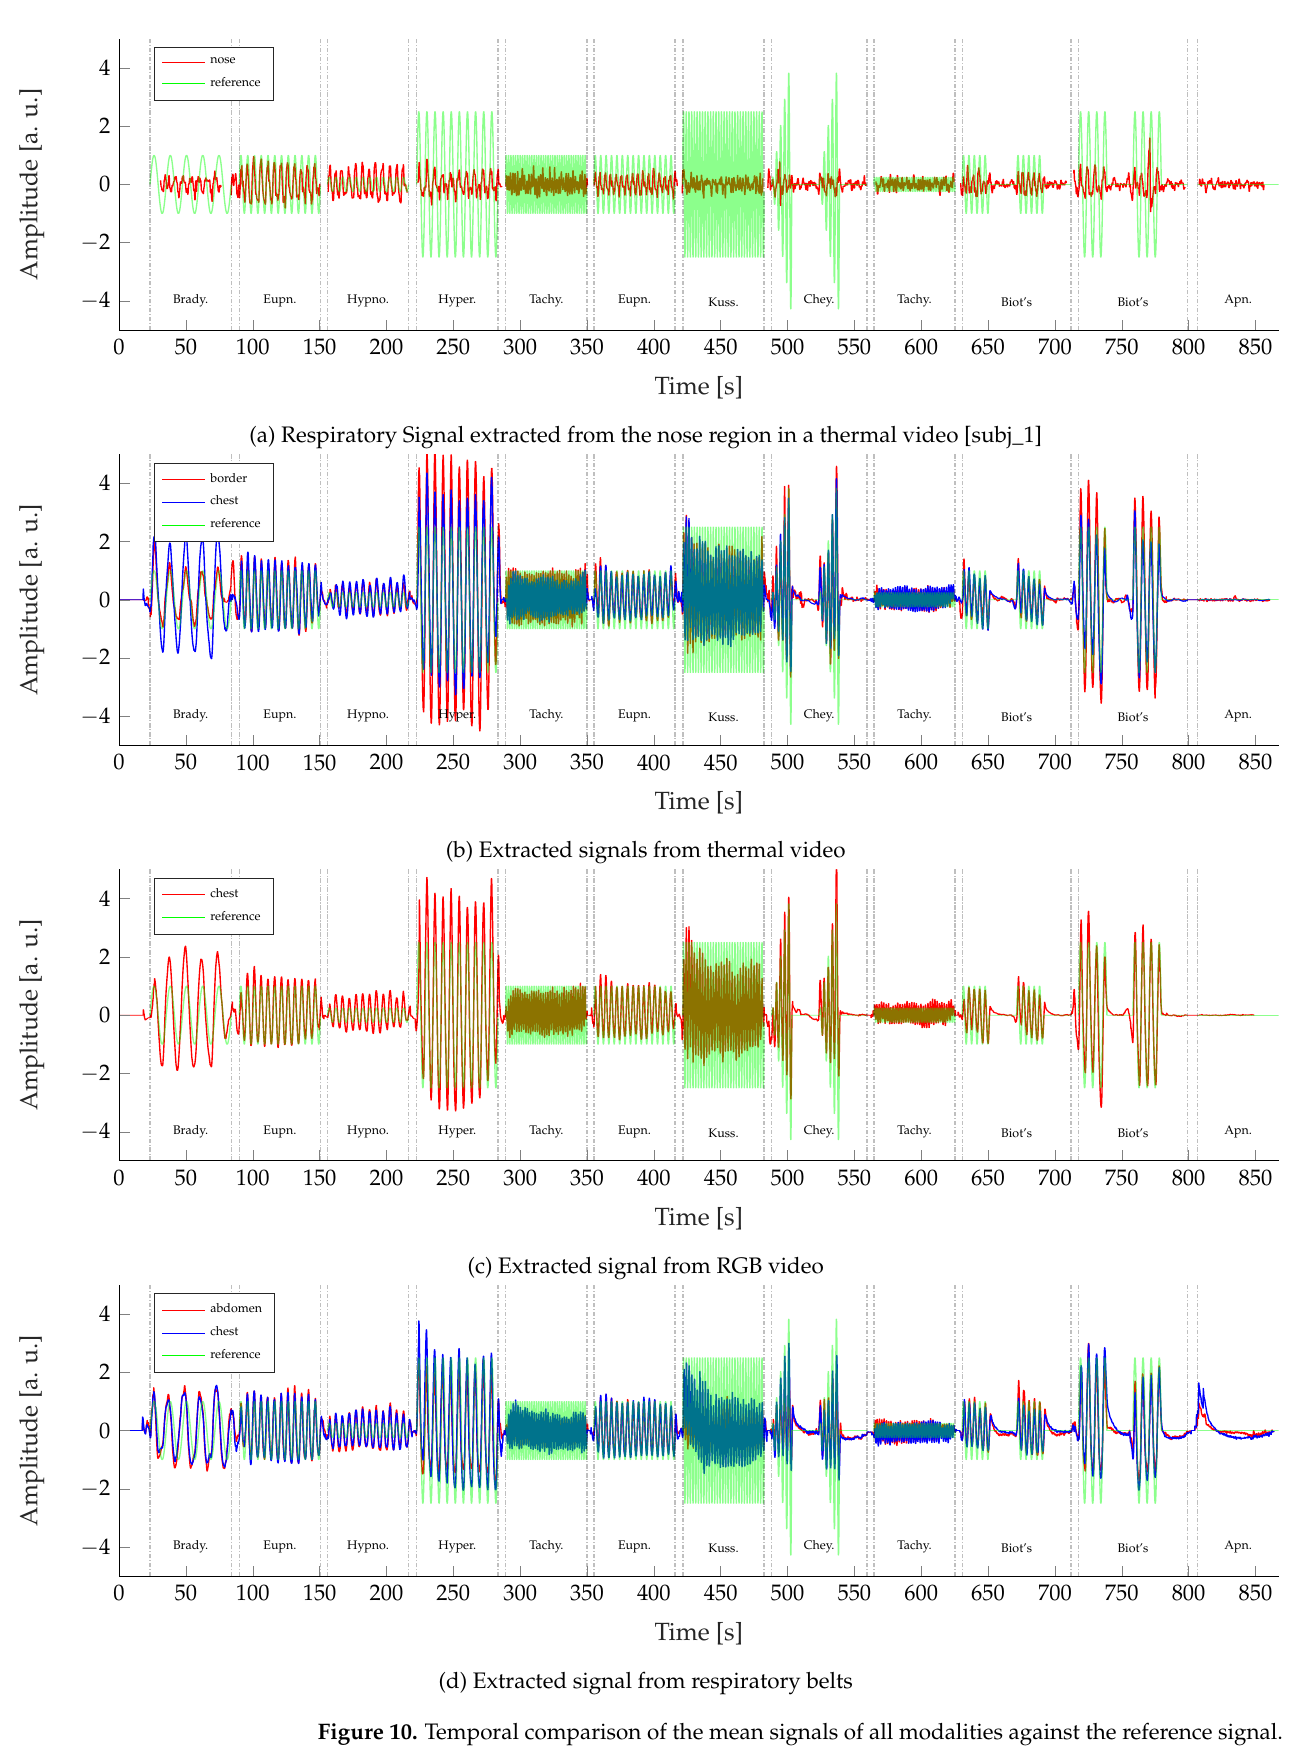
Figure 10. Temporal comparison of the mean signals of all modalities against the reference